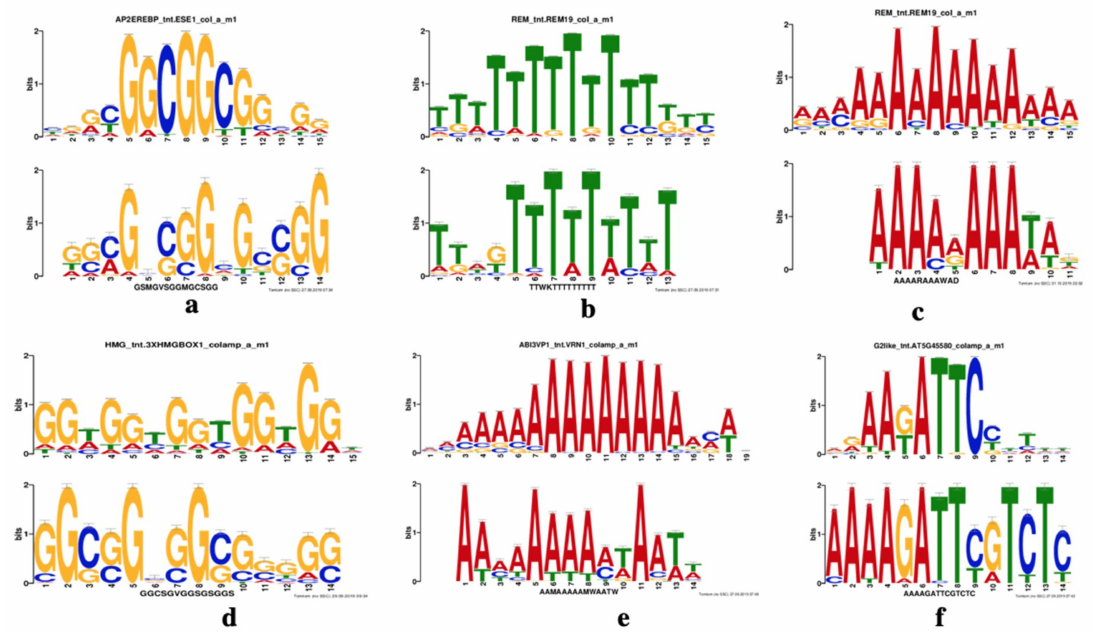
Figure 7. Significant matches in the Arabidopsis TF database are shown for the motifs enriched in the promoter regions of di ff erentially expressed genes in the sorghum drought-tolerant lines (DR1 and DR2) at T = 1 h ( a – c ) and T = 6 h ( d – f ). The enriched motifs were searched against the